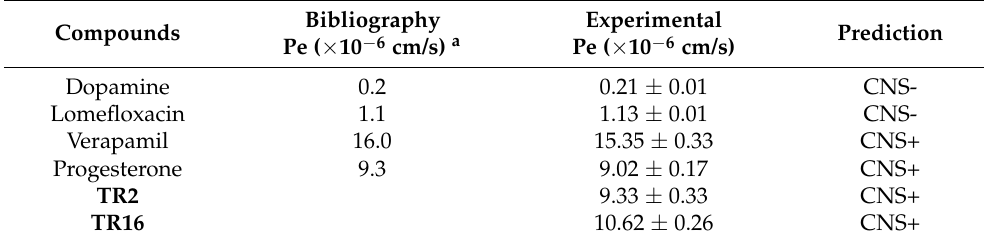
Table 4. BBB permeation of standard and TR compounds by PAMPA.